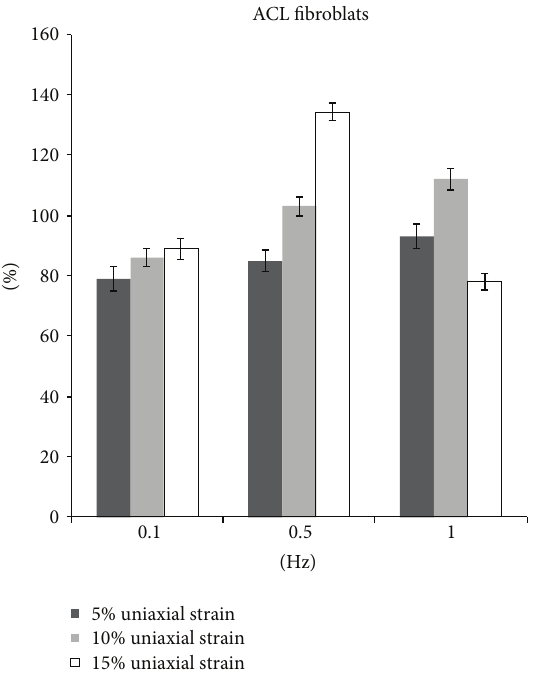
Figure 5: The proliferation of MSCs after uniaxial stretch stimula- tion.